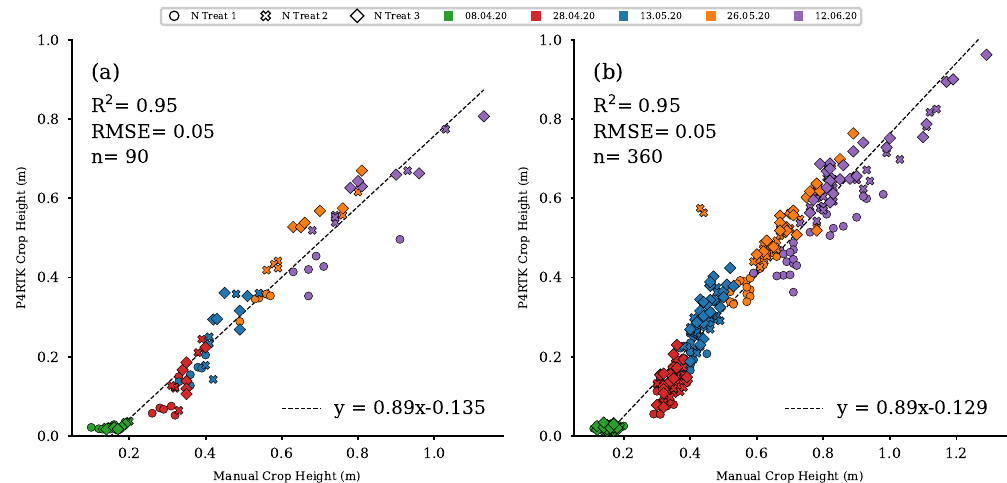
Figure 9. ( a ) Scatter plot for the manually measured CH versus the UAV-based CH for the 18 destructive sampling plots for all five comparable dates. ( b ) Scatter plot for the manually measured CH versus the UAV-based CH for the remaining 72 test plots for all five comparable dates ( p < 0.001 for all regression models).